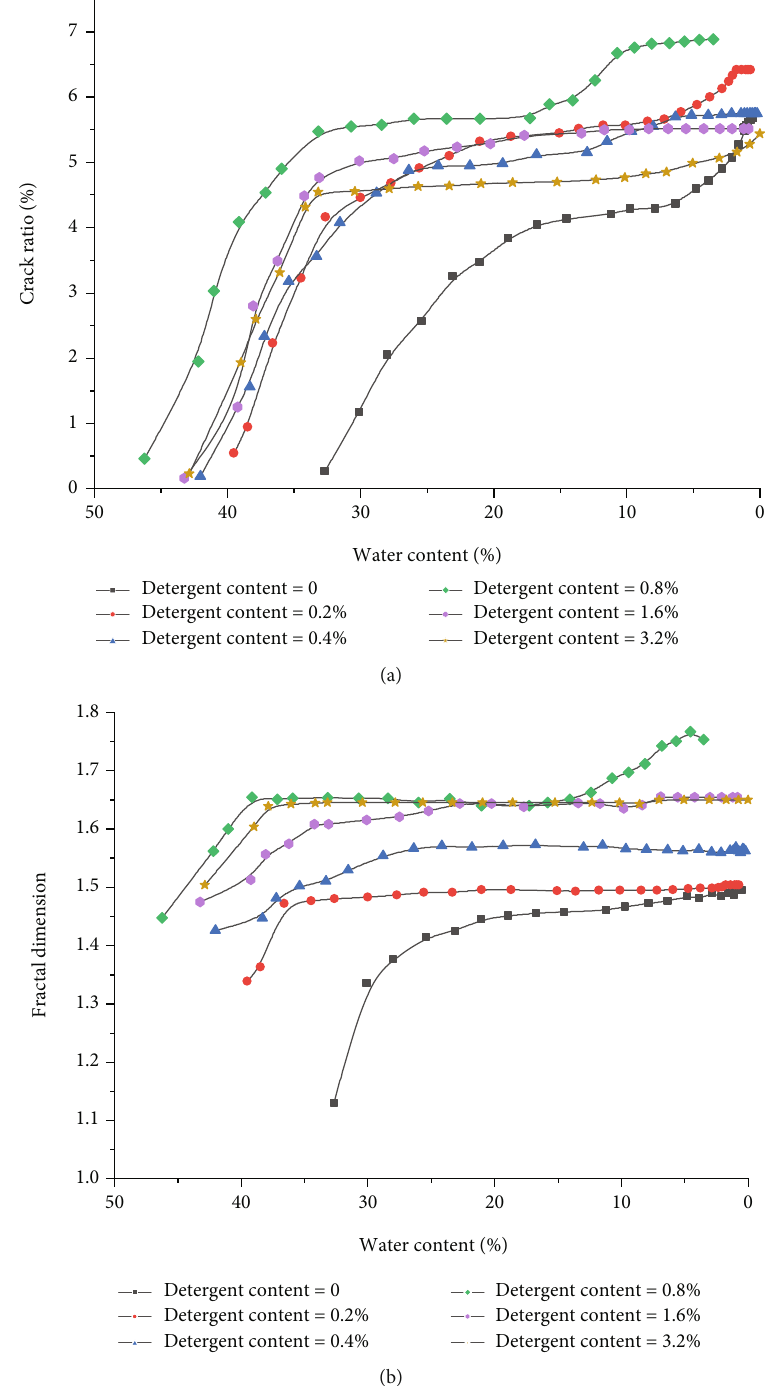
Figure 10: Relationship between the average water content and crack ratio and fractal dimension of soil